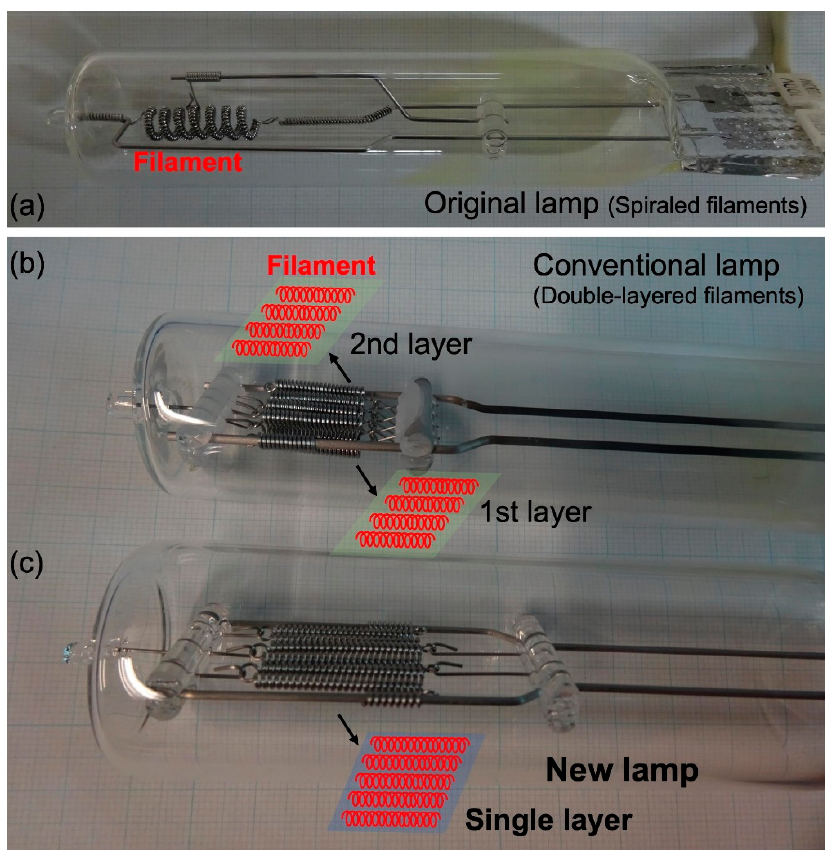
Figure 2. A photograph of ( a ) a halogen lamp with spiral filament, ( b ) a conventional halogen lamp with double-layered filament structure, and ( c ) a new lamp with single-layered filament structure. For clarify, the filament arrays are sketched.